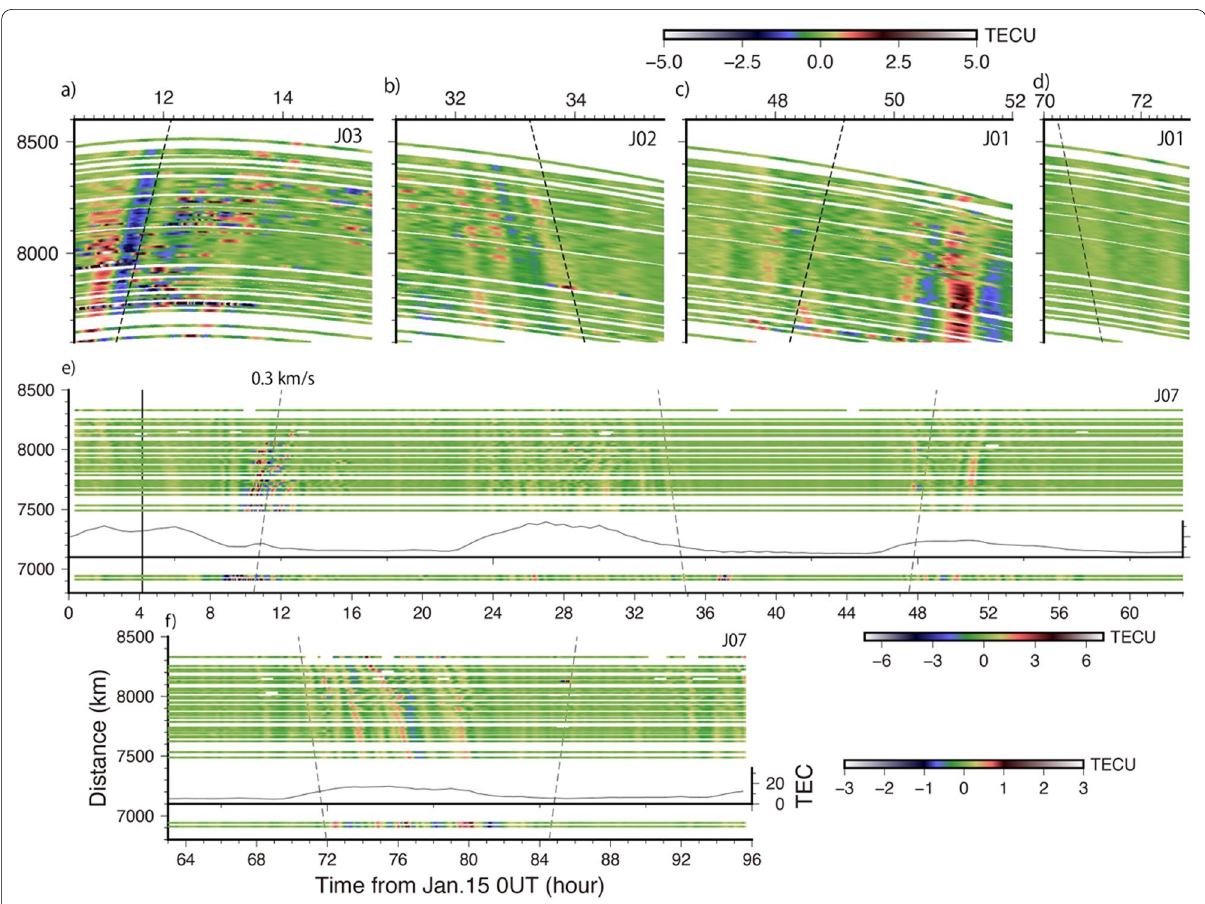
Fig. 6 Wavelet-transformed VTEC time series showing components with periods of ~ 30 min, using QZSS J07 ( e , f ) and J01–03 ( a – d ) data. Dashed lines indicate the expected passage times of a wave propagating with 0.3 km/s. e and f indicate the whole 4 days, while a – d show time windows around the LW passage times. Background VTEC, calculated at (35 N, 135E) using global ionospheric maps (GIM) (ftp.aiub.unibe.ch/CODE/), is shown as gray curves in e and f . Time and distance ranges of a–c are the same as those of Fig. 3a–c, but the distance range of e and f are wider than Fig.